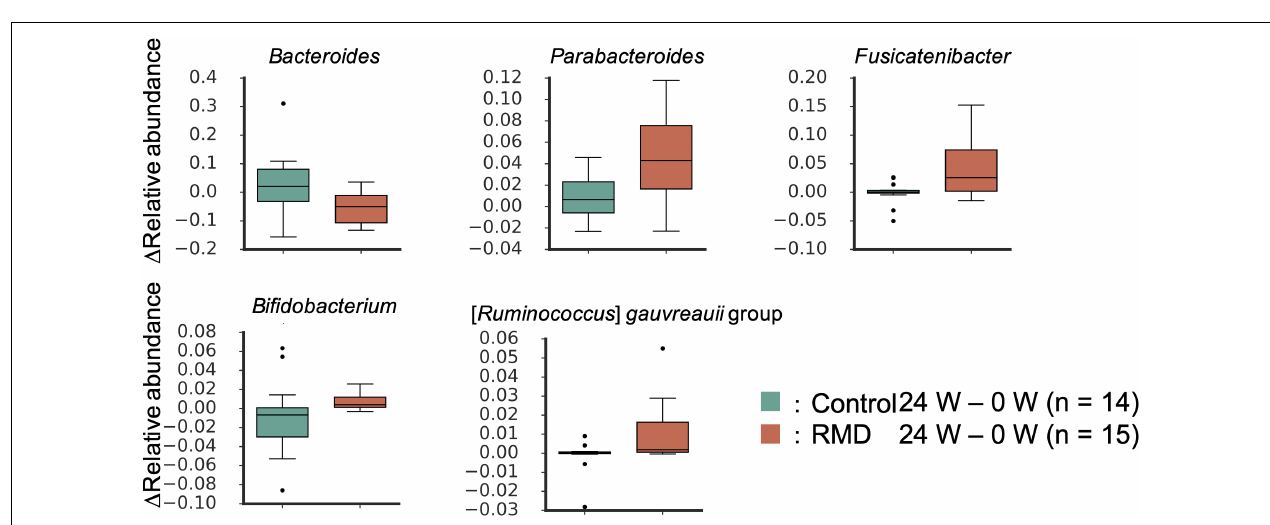
FIGURE 1 | Experimental design of the study and comprehensive analysis of gut microbiome and metabolome profiles. (A) Flow diagram of the double-blind, placebo-controlled parallel group study. Fecal and blood samples were collected 0 and 24 weeks after test food (resistant maltodextrin: RMD) or control food (normal maltodextrin: MD) intervention. Gut microbiome and metabolome analyses, oral glucose tolerance test (OGTT), and blood tests were conducted. (B) Box plot representing distribution of unweighted UniFrac distance for the gut microbiome profiles among the samples from different subjects at the same time point (inter 0 week) and the distance between the samples from the same subject in the control group and RMD group (** p < 0.005, *** p < 0.0005; the Dunn’s test). (C) Box plot representing the distribution of the Spearman’s correlation distance for intestinal metabolome profiles among the samples from different subjects at the same time point (inter 0 week) and the distance between the samples from the same subject in the control group and RMD group (** p < 0.005, *** p < 0.0005; the Dunn’s test).